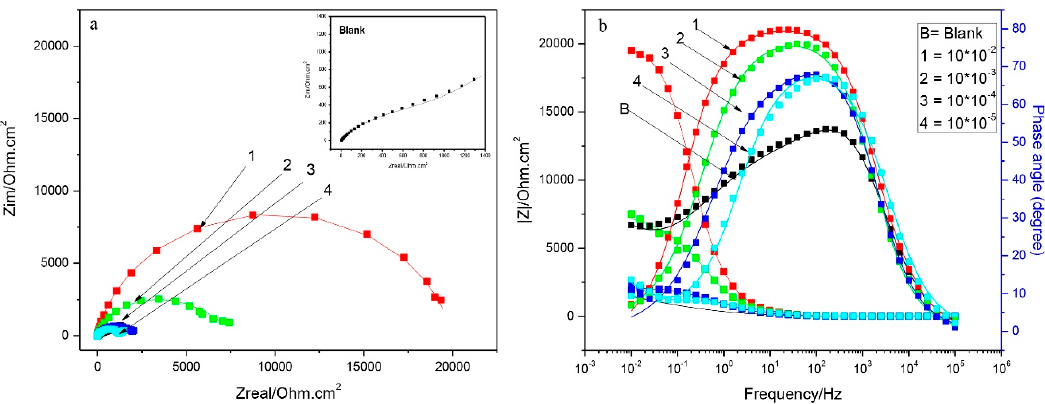
Figure 2. Nyquist ( a ) and Bode ( b ) plots for the Cu5Zn5Al1Sn alloy in 3.5 wt.% NaCl with and without different concentrations of cysteine (10 -5 to 10 -2 ) (scattered: experimental data; lines: fitting data).